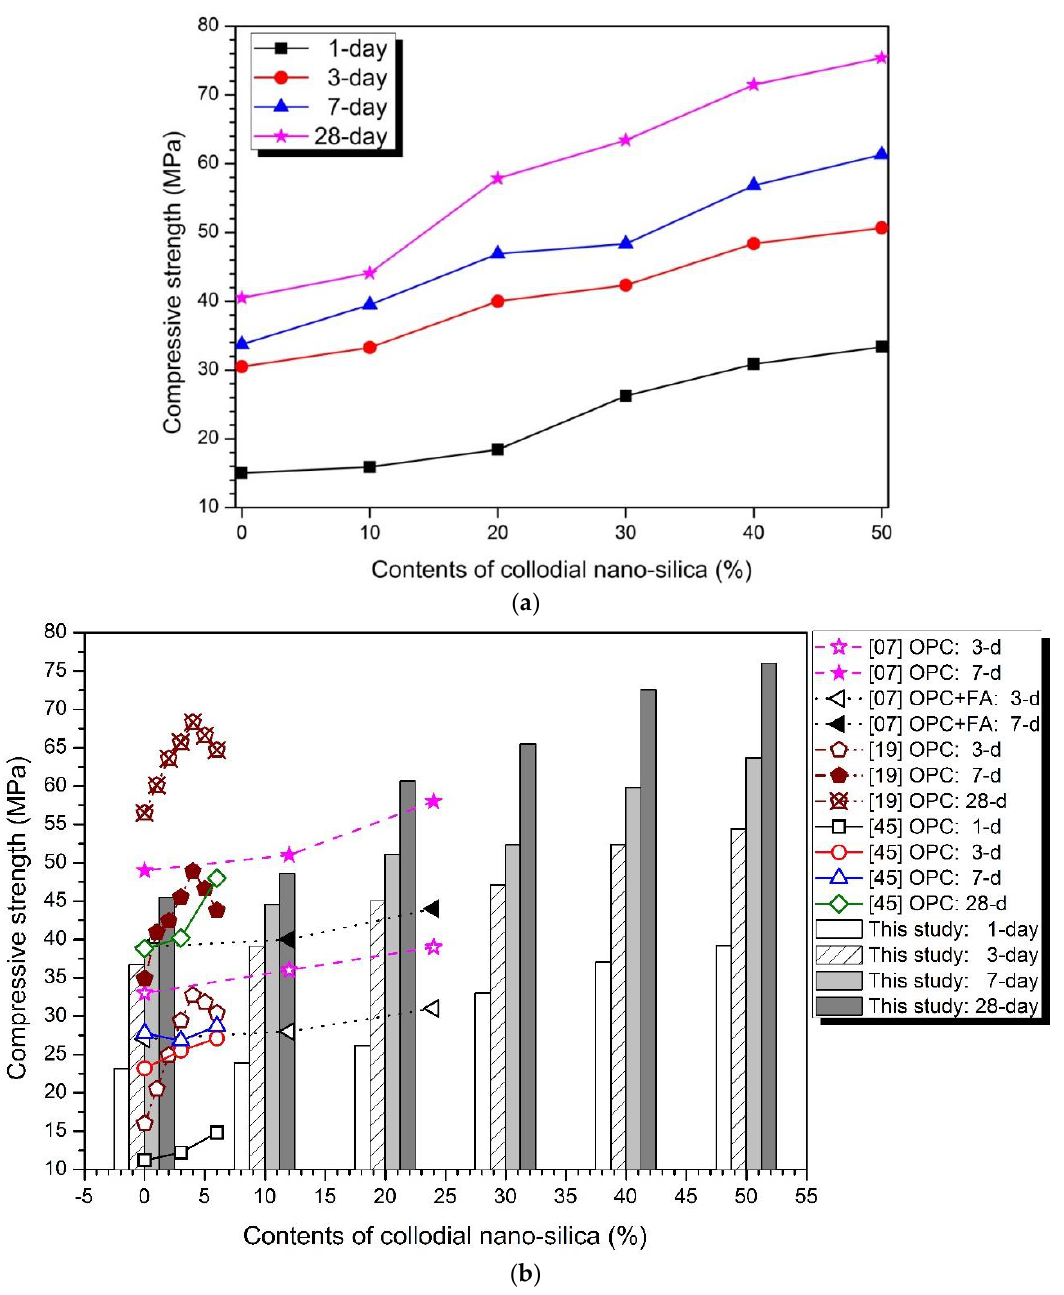
Figure 3. CNS replacement ratio and compressive strength according to age ( a ) this study, ( b ) compared with previous studies.